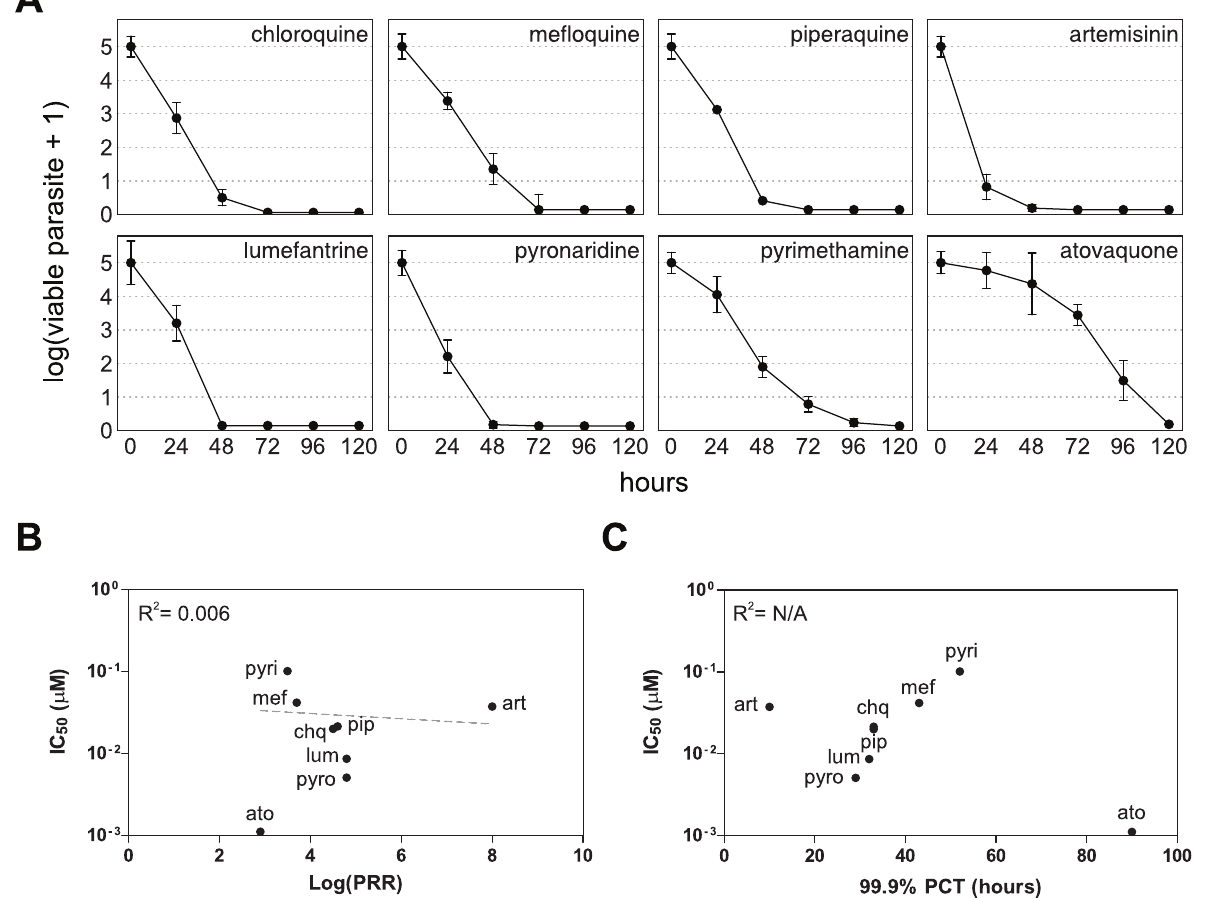
Figure 3. Parasite viability in response to various classical antimalarial drugs. A. P. falciparum viability time-course profiles for chloroquine (chq), mefloquine (mef), piperaquine (pip), artemisinin (art), lumefantrine (lum), pyronaridine (pyro), pyrimethamine (pyri), and atovaquone (ato). Error bars represent the SEM of at least 4 independent experiments. B . and C . Scatter plots of the compounds tested reporting the IC 50 versus the log(PRR) and 99.9% PCT, respectively. The dotted line in panel B is a log linear regression, the slope thereof is not significantly different from zero ( p =0.48). Data of panel C do not converge enough to establish a regression line.